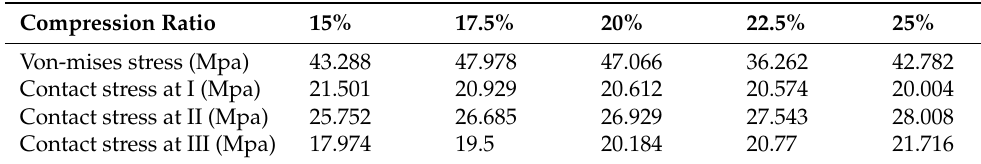
Table 4. Contact stress and compression ratio (working pressure 20 MPa).